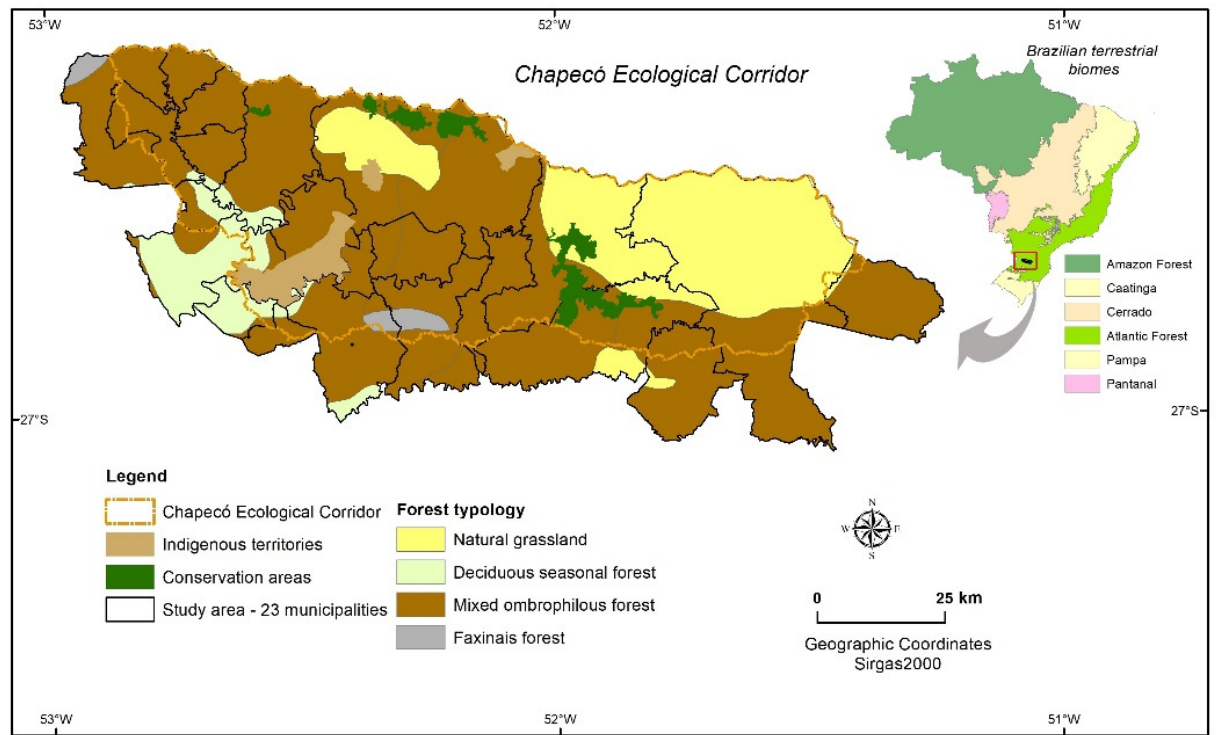
Figure 2. Forest tipology (Atlantic Forest biome) in CHapecó CE.